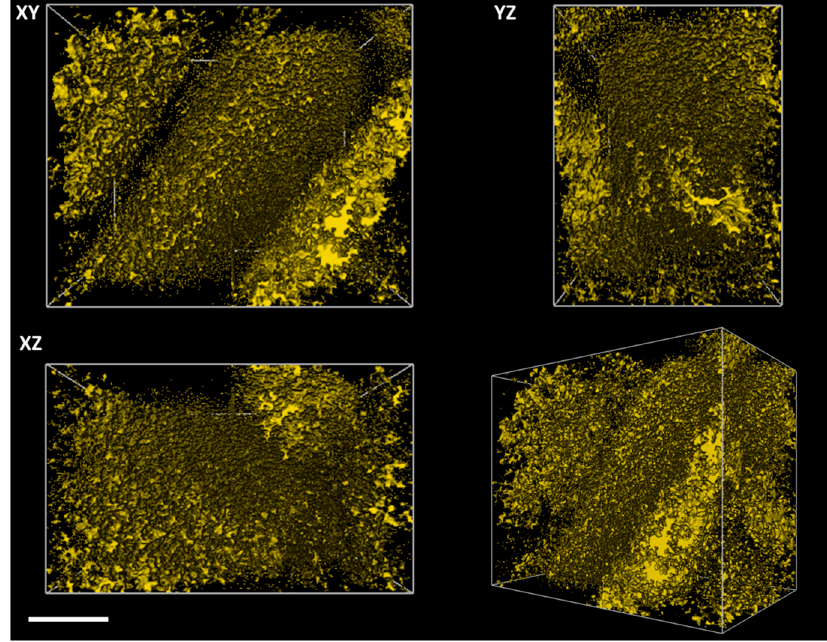
Figure 10. 3D rendering of the pores in the explored volume of 23 × 19 × 15 µm 3 from the reacted olivine sample, shown in four different orientations. The scale bar is 5 µm.